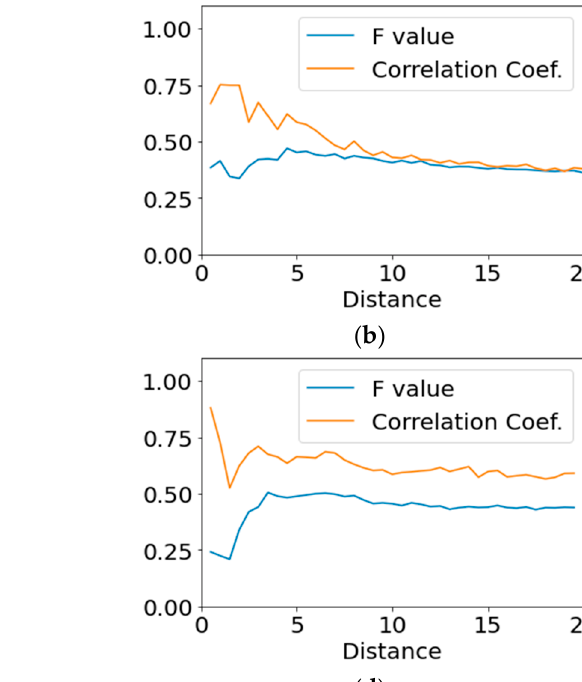
Table 15. Correlations obtained for the set of sites 1, 2 and 3.